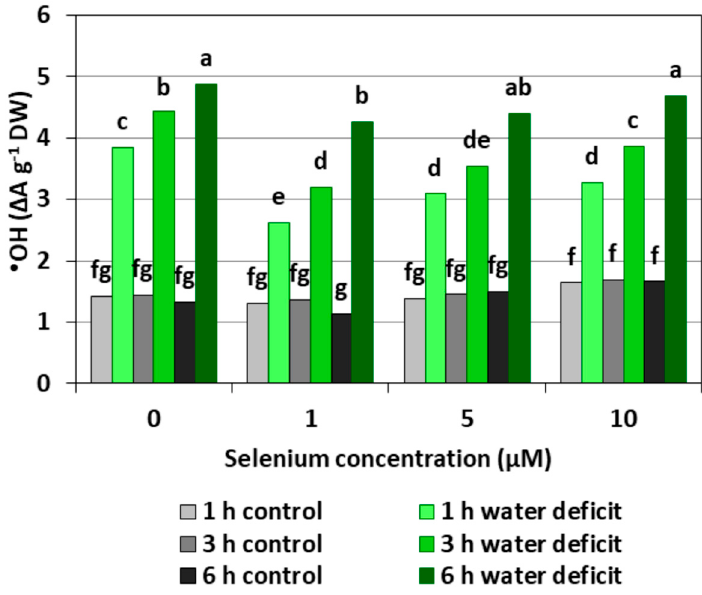
Figure 3. The hydroxyl radical ( • OH) level in the roots of cucumber seedlings pre-treated with Se and subjected to a WD. Bars marked with the same letters do not differ significantly at p < 0.05.